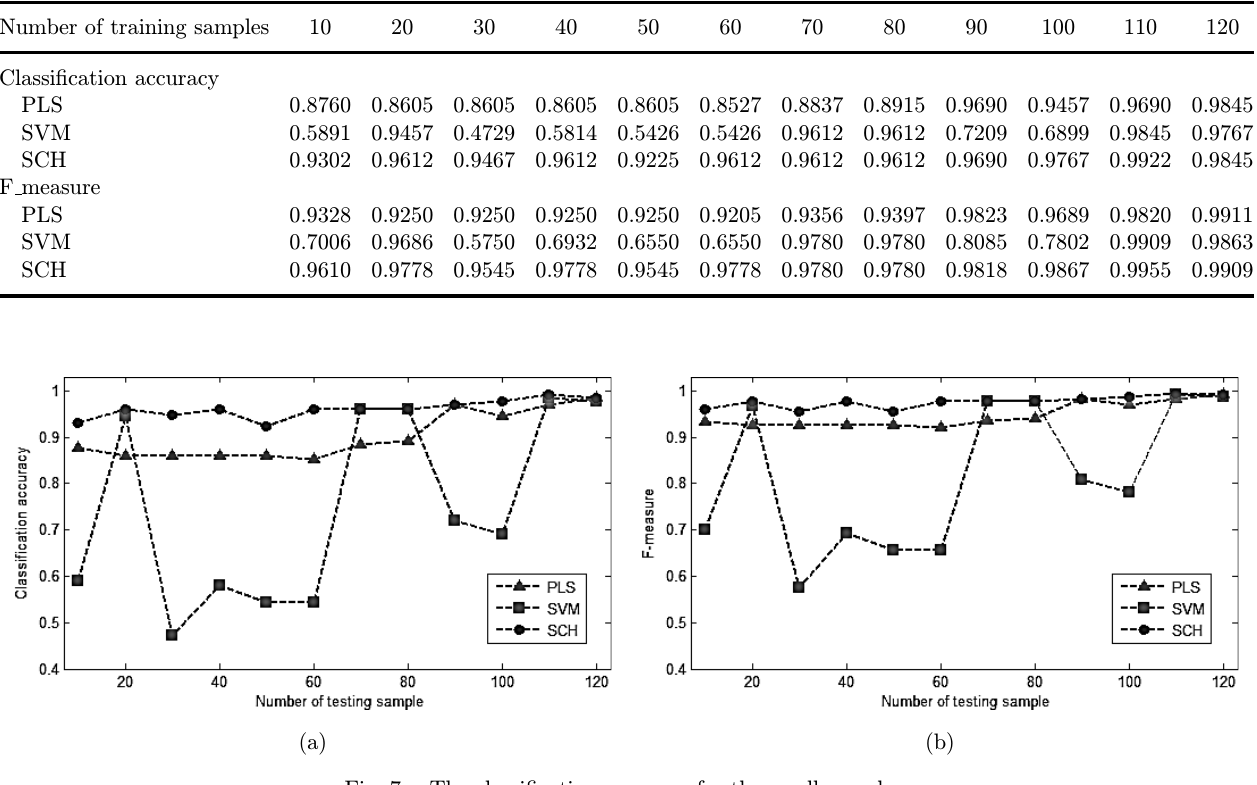
Table 3. Classi¯cation accuracy table for the small samples.